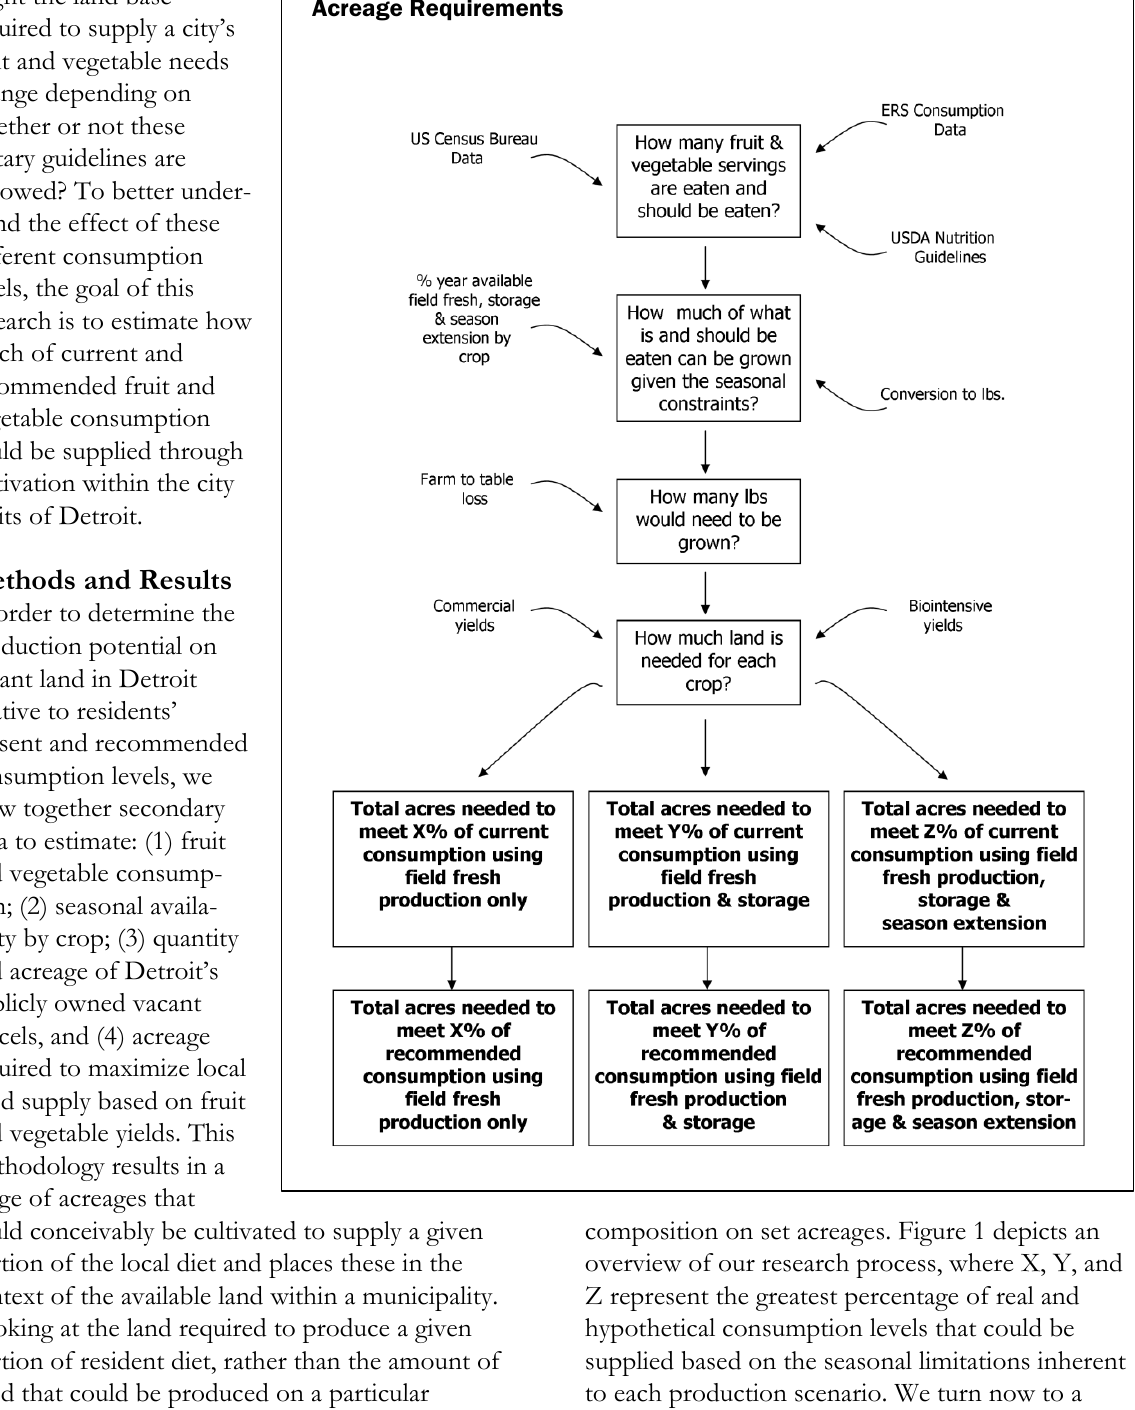
Figure 1. Overview of the Process to Determine Fruit and Vegetable Acreage